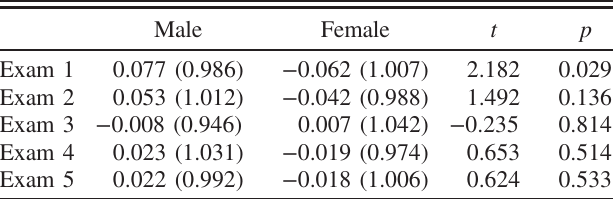
TABLE VI. Average exam z scores (and standard deviation) for algebra-based E&M, as well as the t test and significance between these